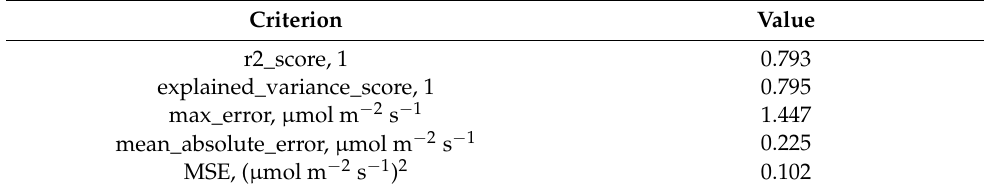
Table 5. The results of experiment 5.